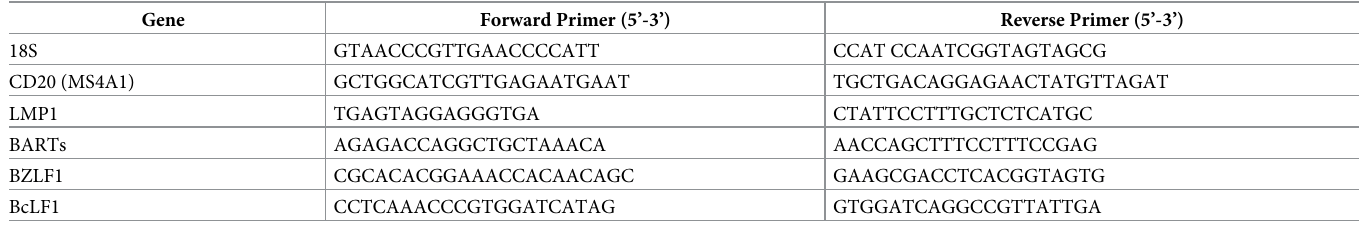
Table 4. The primers used for qPCR analysis in this study.